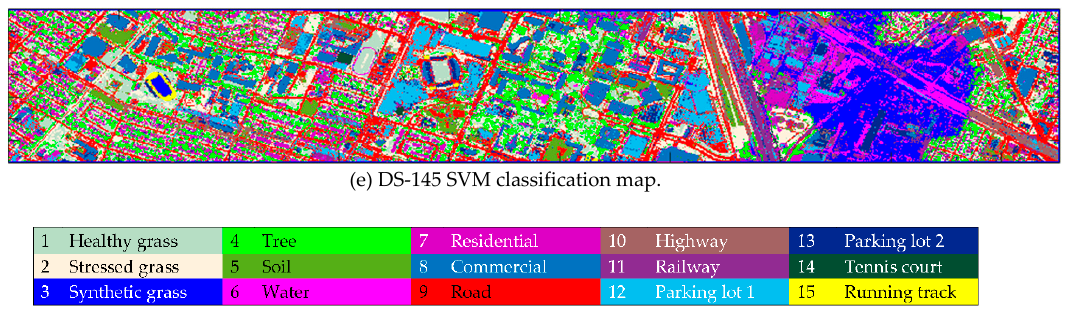
Figure A9. SVM classification maps.